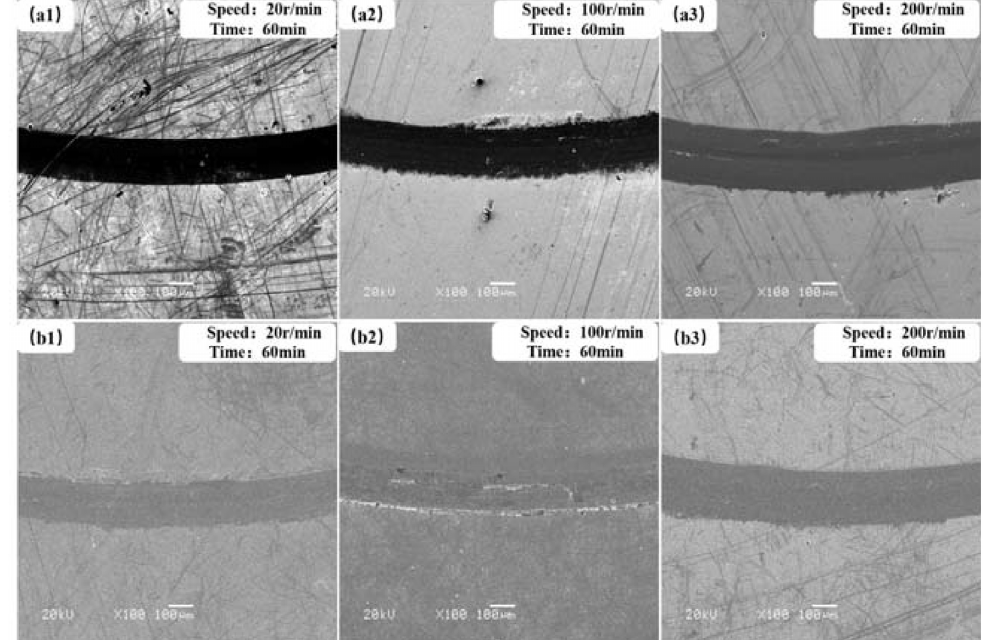
Figure 11. The morphologies of the wear tracks for pure MoS 2 film ( a1 – a3 ) and the MoS 2 –WS 2 composite film ( b1 – b3 ) after atomic oxygen irradiation at varying sliding speeds. Reproduced with permission from [111]. Copyright 2020 MDPI AG.